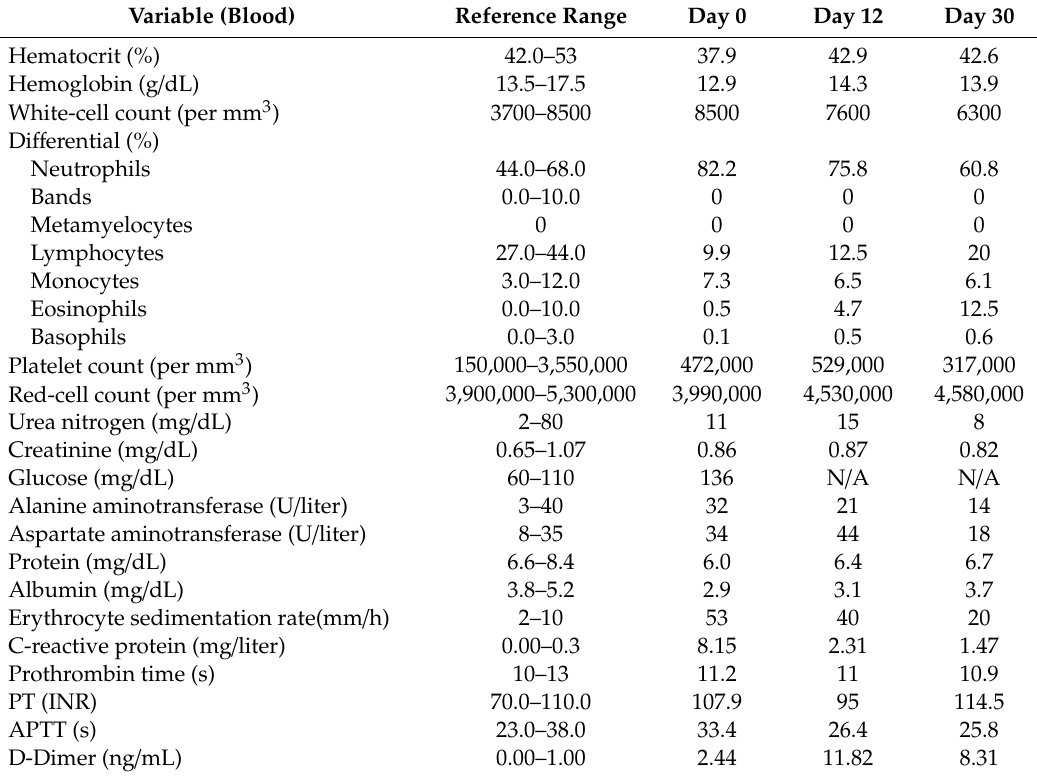
Figure 1. Chest X-ray from ( A ) the first visit, ( B ) at day 12, ( C ) at day 30, and ( D ) at day 60. Table 1. Laboratory data.